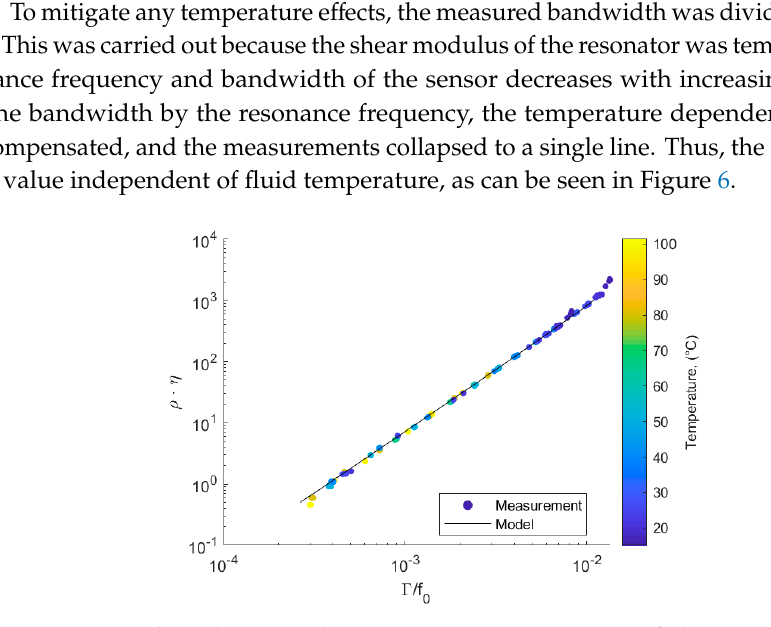
Figure 5. Velocity profile for different fluids in a tubular sensor with a frequency of 10,800 Hz and density of 1000 kg/m 3 .